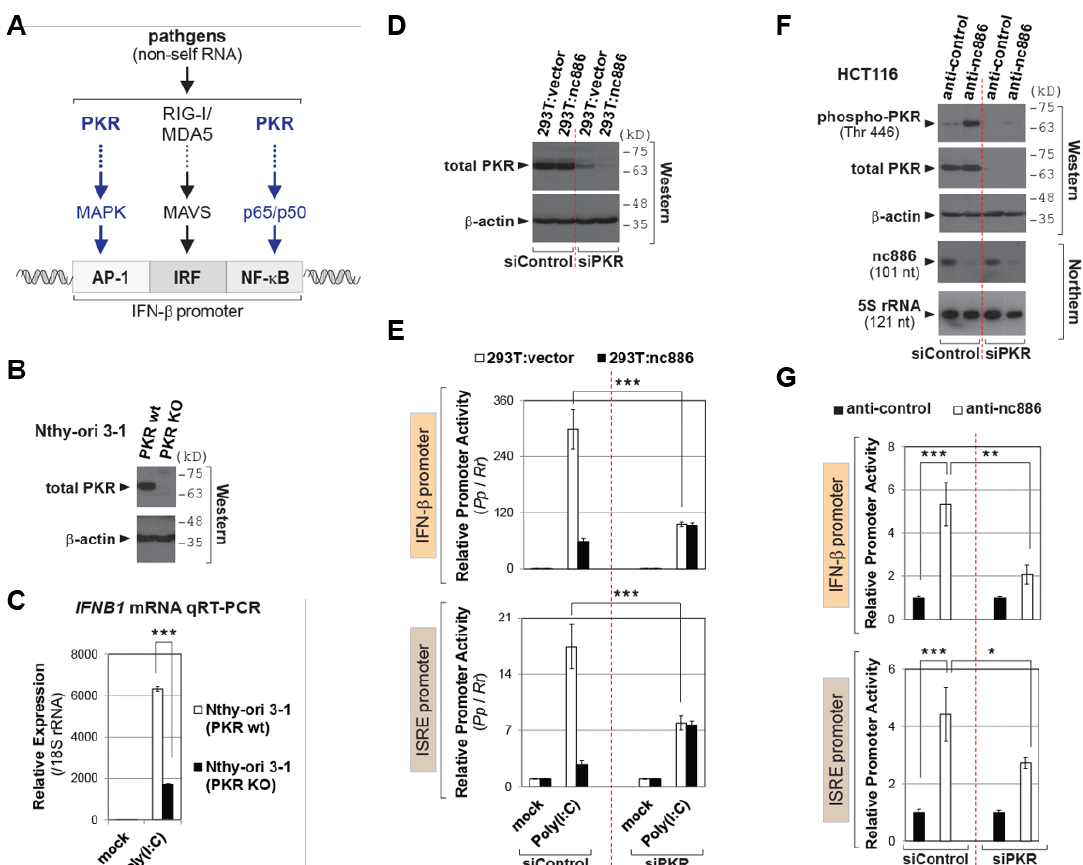
Figure 2. nc886 suppresses the IFN promoter via inhibiting PKR. ( A ) Image showing the IFN- β promoter as well as regulatory factors and pathways. ( B ) Western blot of PKR and β -actin as a loading control. ( C ) qRT-PCR as described in Figure 1C. 2 − ∆∆ Ct values were relative to the mock transfected PKR wt sample. ( D ) Western blot of PKR and β -actin as in panel B. ( E ) Luciferase assays for the reporter plasmid indicated on the left. Initial siRNA transfection (0 h); transfection of luciferase plasmids at 12 h, cell harvest and assays at 36 h. All other information is the same as Figure 1D. ( F ) Western and Northern blot of indicated proteins and RNAs, at 24 h after co-transfection of indicated siRNAs and anti-oligos. ( G ) Luciferase assays, as described in panel E and F. Luciferase plasmids were co-transfected with siRNAs and anti-oligos. One, two, and three asterisks designate a p -value less than 0.05, 0.01, and 0.001,